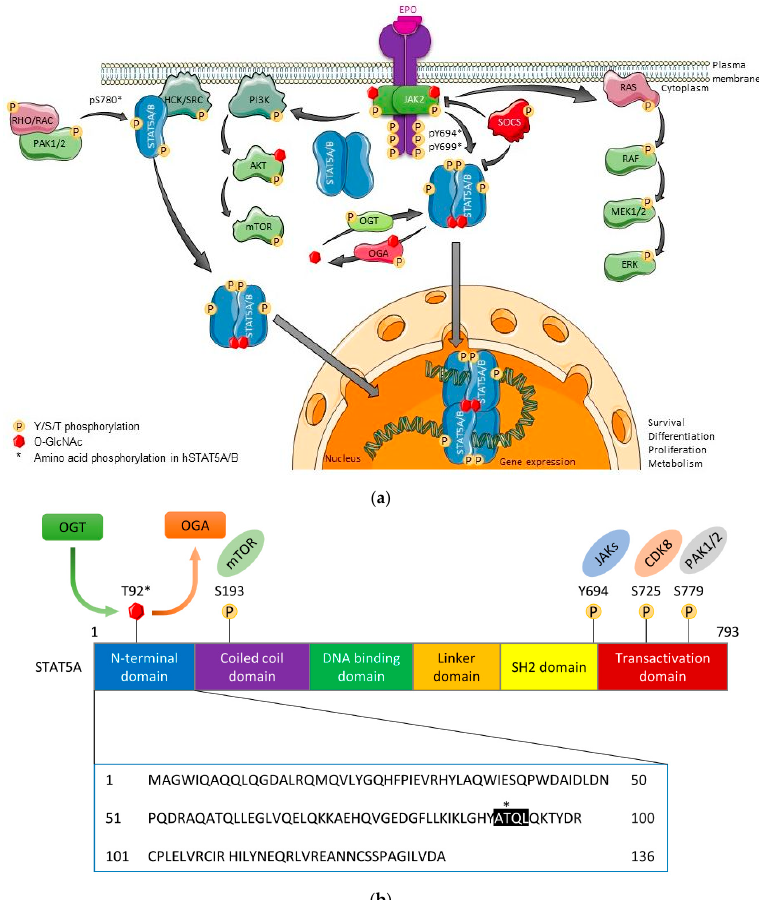
Figure 1. The JAK2-STAT5-SOCS pathway and domain structure of STAT5. ( a ) Upon cytokine binding to respective cytokine receptor chain(s), a conformational change in the transmembrane domain triggers activation of associated Janus kinase (JAK) kinases that bind to the BOX1 and BOX2 membrane proximal motifs. Subsequently, antiparallel STAT5 dimers are efficiently recruited and JAK dimers then activate STAT5 by tyrosine phosphorylation. STAT5 then undergoes a drastic conformational change to form parallel dimers. Furthermore, serine/threonine phosphorylation of STAT family members triggers shuttling in and out of the nucleus as well as transcriptional elongation. STATs are usually inactivated by tyrosine phosphatases, which are much more highly expressed than the rate limiting JAK kinases. In contrast, inhibition of cytokine receptor and JAK kinase signaling is executed via ubiquitination by SOCS family members, downstream targets of STATs that provide negative feedback control. JAK2 glycosylation is also observed (our unpublished data). ( b ) The STAT5A domain structure is schematically illustrated with the O-GlcNAc modification depicted at T92 (indicated by asterisk) within an ATQL motif (highlighted in black) in the N-domain. STATs consist of six domains: N-terminal domain (blue), coiled coil domain (purple), DNA binding domain (green), linker domain (orange), SH2 domain (yellow) and transcriptional activation/stability domain (red) [15,16,19]. Reported phosphorylation sites and respective kinases are also shown. OGT, O-GlcNAc transferase; OGA,